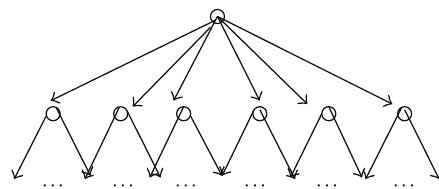
Figure 5: The Bratteli diagram of a cluster 𝐶 ∗ -algebra of rank 6